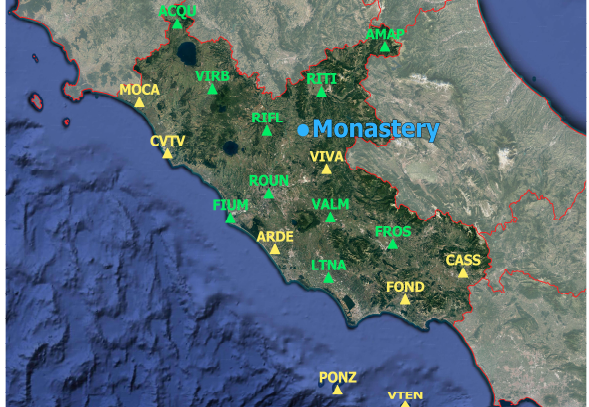
Figure 3 . Regione Lazio GNSS network. The green stations were used in the computation of the VRS.